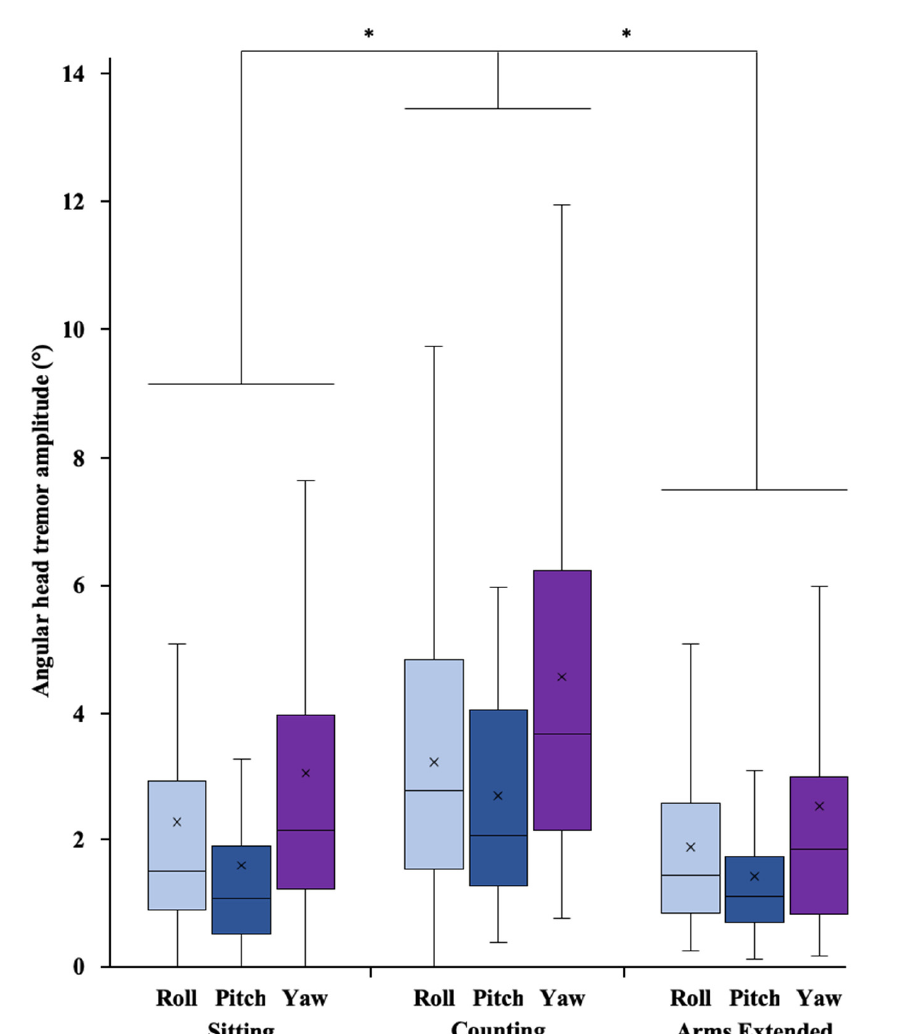
Figure 4. Box plots of the angular head tremor amplitude obtained from the IMMU data around the x (forward–backward bending, roll), y (left–right rotation, pitch), and z (lateral bending, yaw) axes in the sitting, counting and arms extended conditions. In each box, the center line and the cross represent the median and the mean value, respectively; the top and bottom of the box correspond to the 25th and 75th percentiles; and the whiskers represent the 10th and 90th percentiles. Note: * indicates a significant difference between conditions; all pairwise differences among the axes were significant ( p < 0.05).